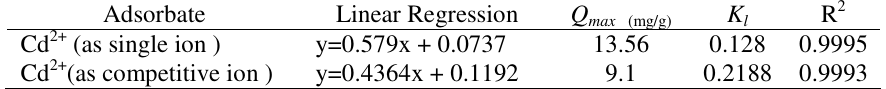
Table 3. Comparison of Langmuir constants for Cd 2+ as single ion and as competitive ion